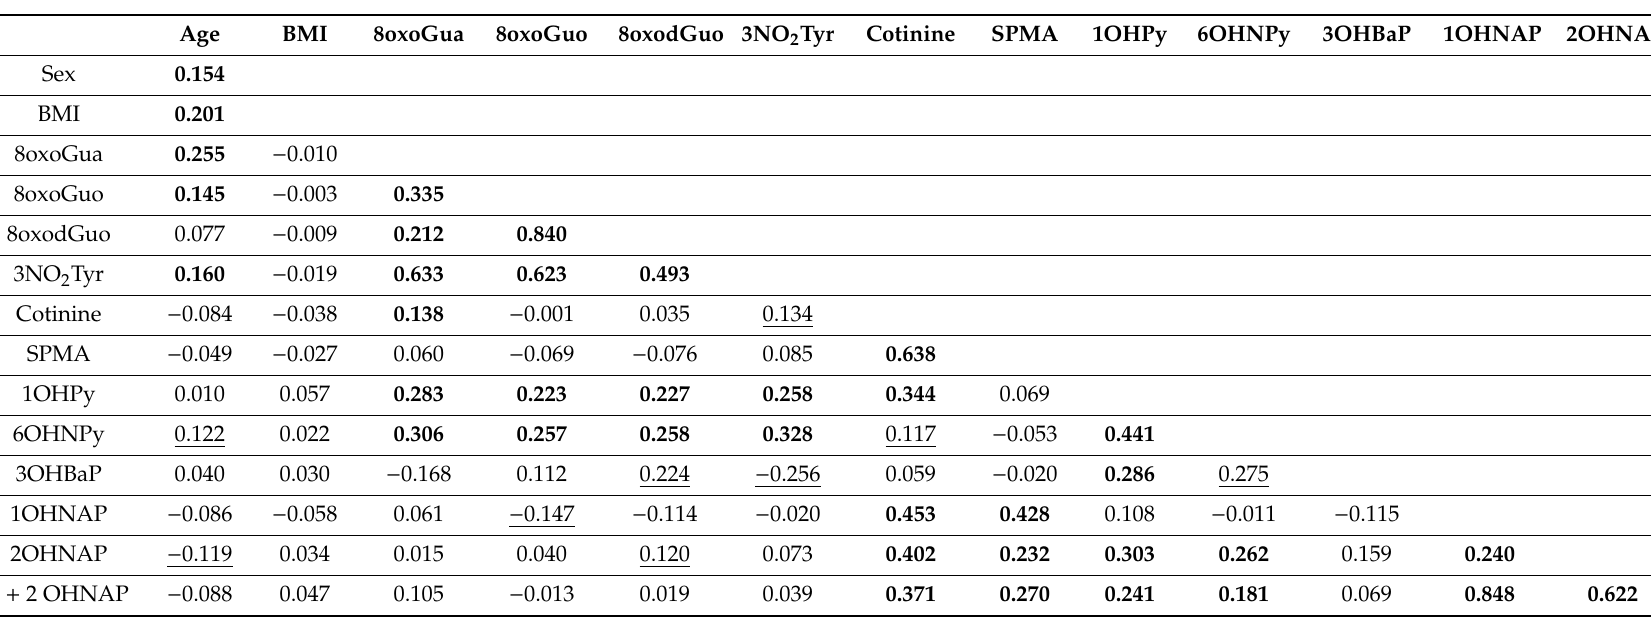
Table 5. Pearson’s correlation on the log-transformed values of oxidative stress biomarkers and exposure biomarkers on 322 complete results. (Underlined: p < 0.05; bold: p <